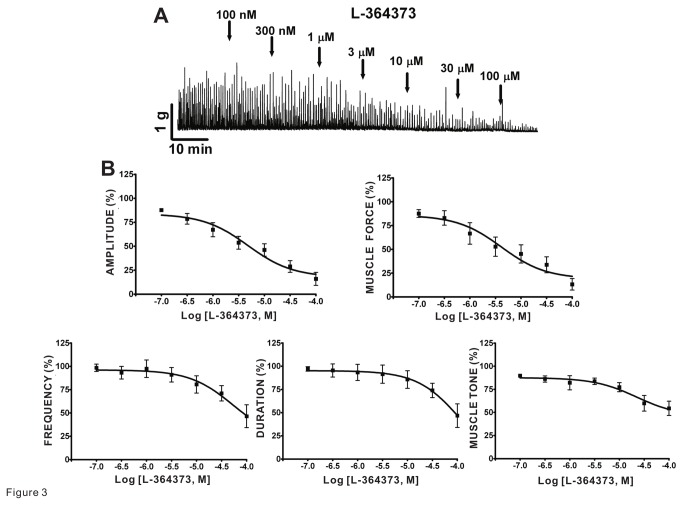
Kv7.1 channel activator L-364373 inhibited spontaneous phasic contractions in guinea pig DSM isolated strips.
A) This original DSM tension recording illustrates L-364373 inhibitory effect on spontaneous phasic contractions of DSM isolated strips in a concentration-dependent manner. B) Cumulative concentration-response curves for L-364373 show significant reduction in DSM spontaneous phasic contraction amplitude, muscle force, frequency, duration, and muscle tone (n=7, N=4); see Table 1 for potency and maximum efficacy values. TTX (1 µM) was present throughout the experiments.